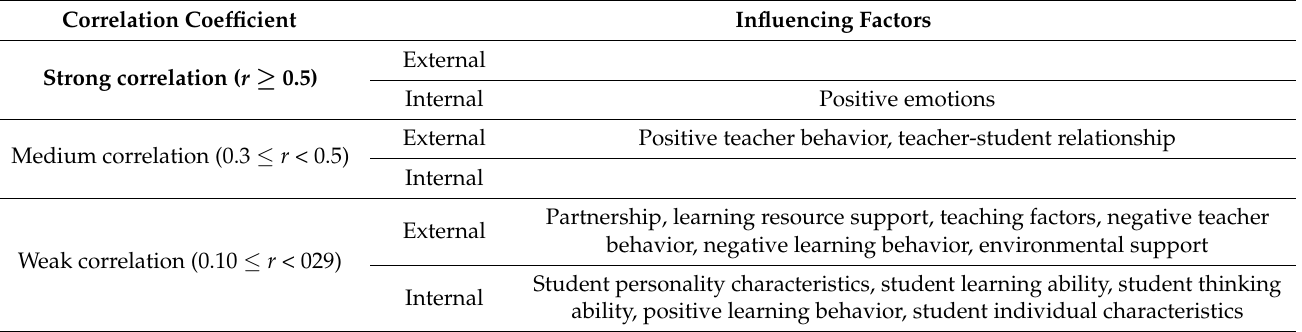
Table 5. Correlation of influencing factors on students’